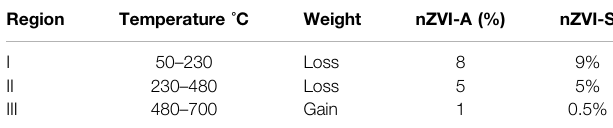
TABLE 3 | Regions of weight loss and gain (%) of nZVI-A and nZVI-S